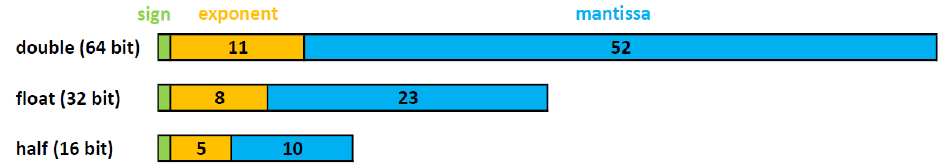
Figure 2. Encodings of the floating-point